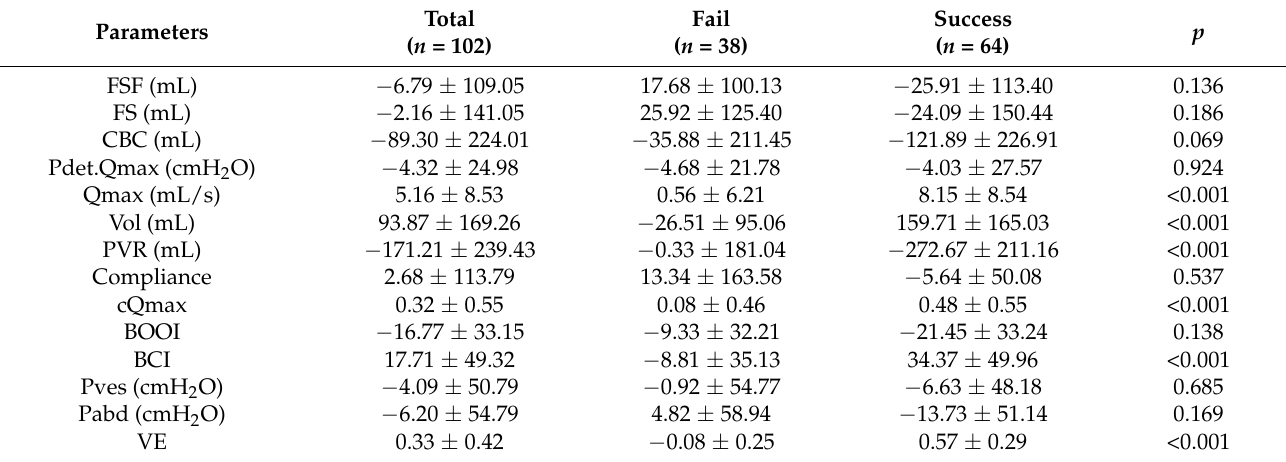
Table 2. The changes of videourodynamic study parameters after